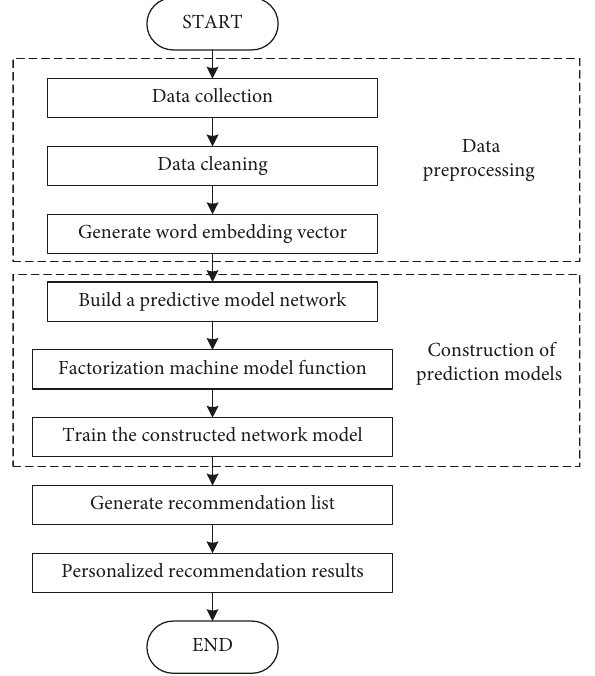
Figure 1: Implementation flow of the proposed recommendation